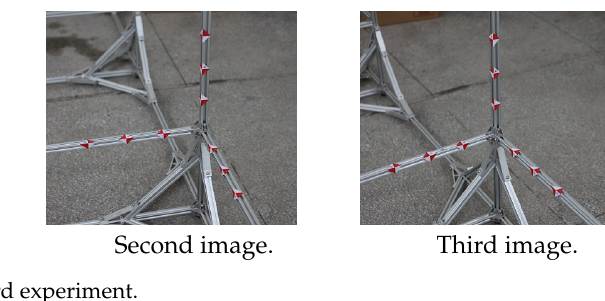
Figure 6. Images of the third experiment.